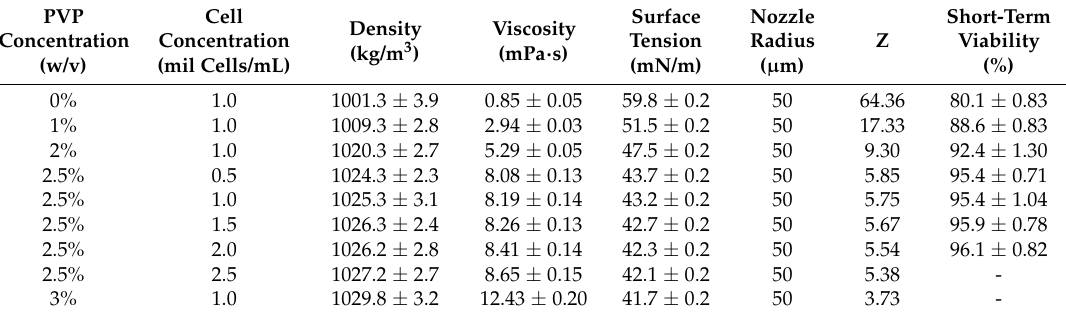
Table 1. Influence of polymer concentration and cell concentration on properties (Z values) of PVP-based bio-inks and their corresponding short-term cell